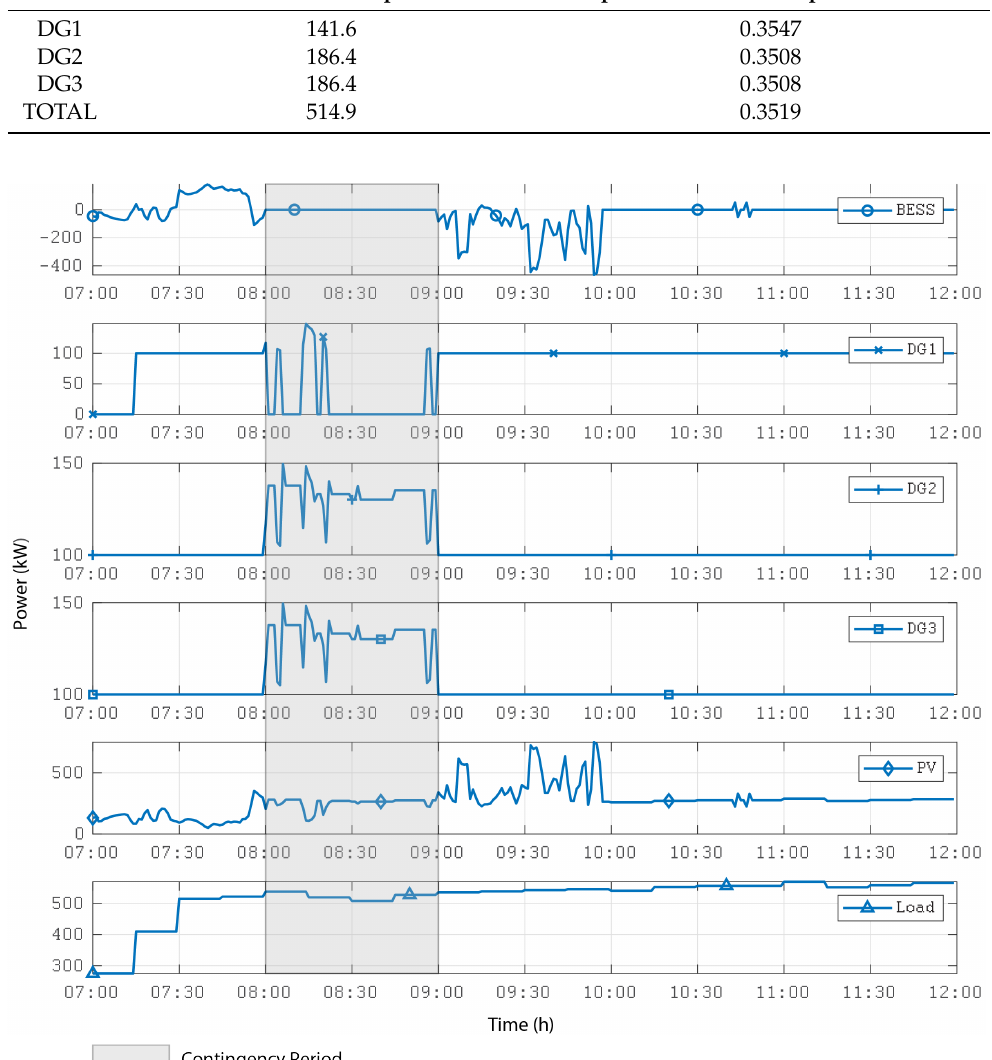
Figure 9. DERs generation and ASC load curves for off-grid operation (case with BESS outage and PV plant limited to 50% of ASC